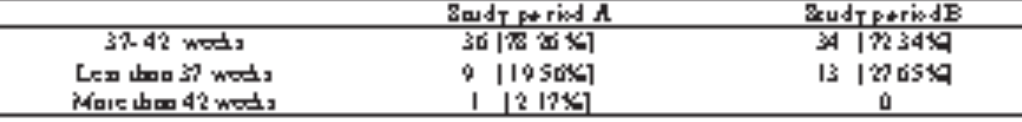
Table V : Duration of gestation at the onset of fit